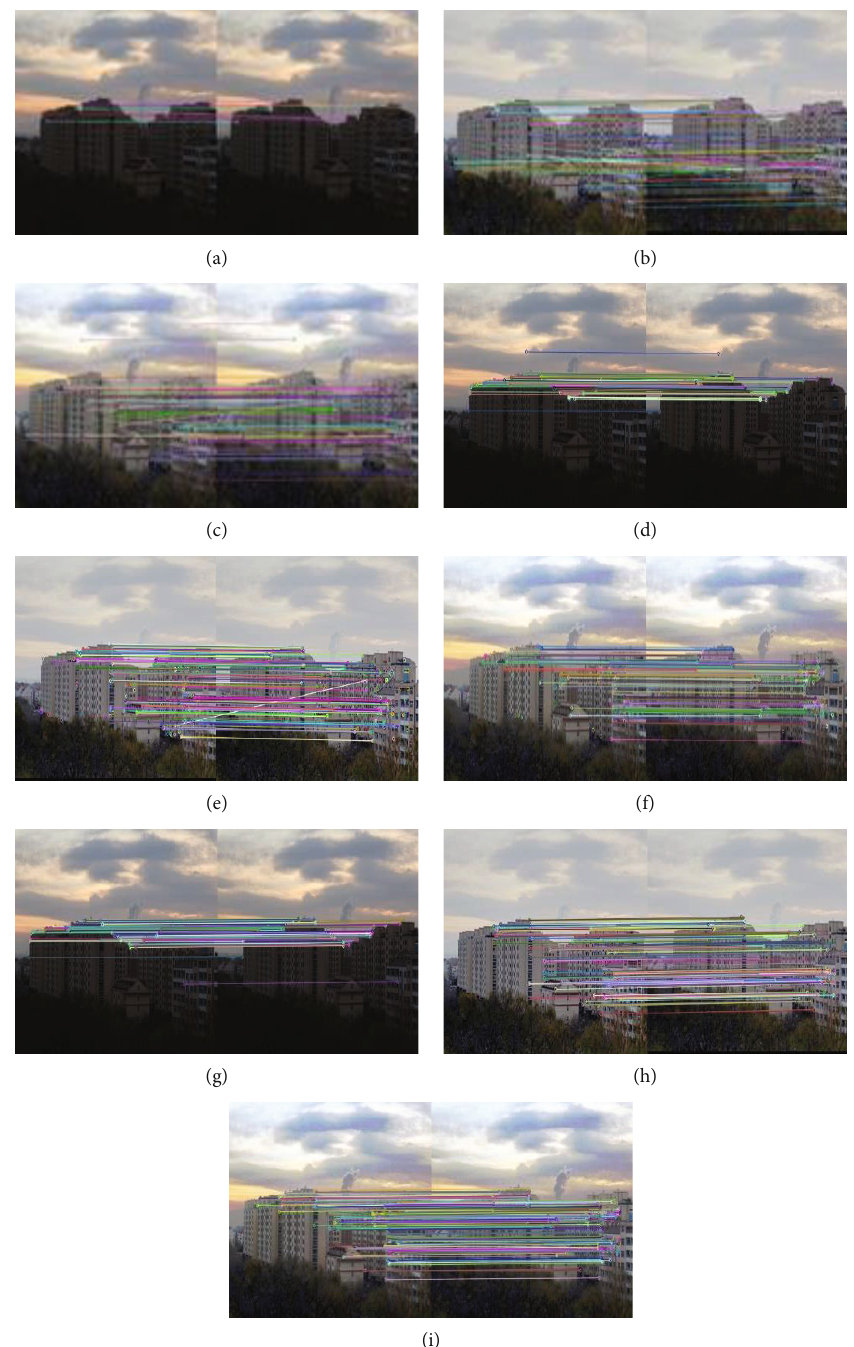
Figure 8: Scene 2: (a) SURF; (b) SURF+MSRCR; (c) SURF+Improved MSR; (d) ORB; (e) ORB+MSRCR; (f) ORB+Improved MSR; (g) ORB+PROSAC; (h) ORB+PROSAC+MSRCR; (i) method in this